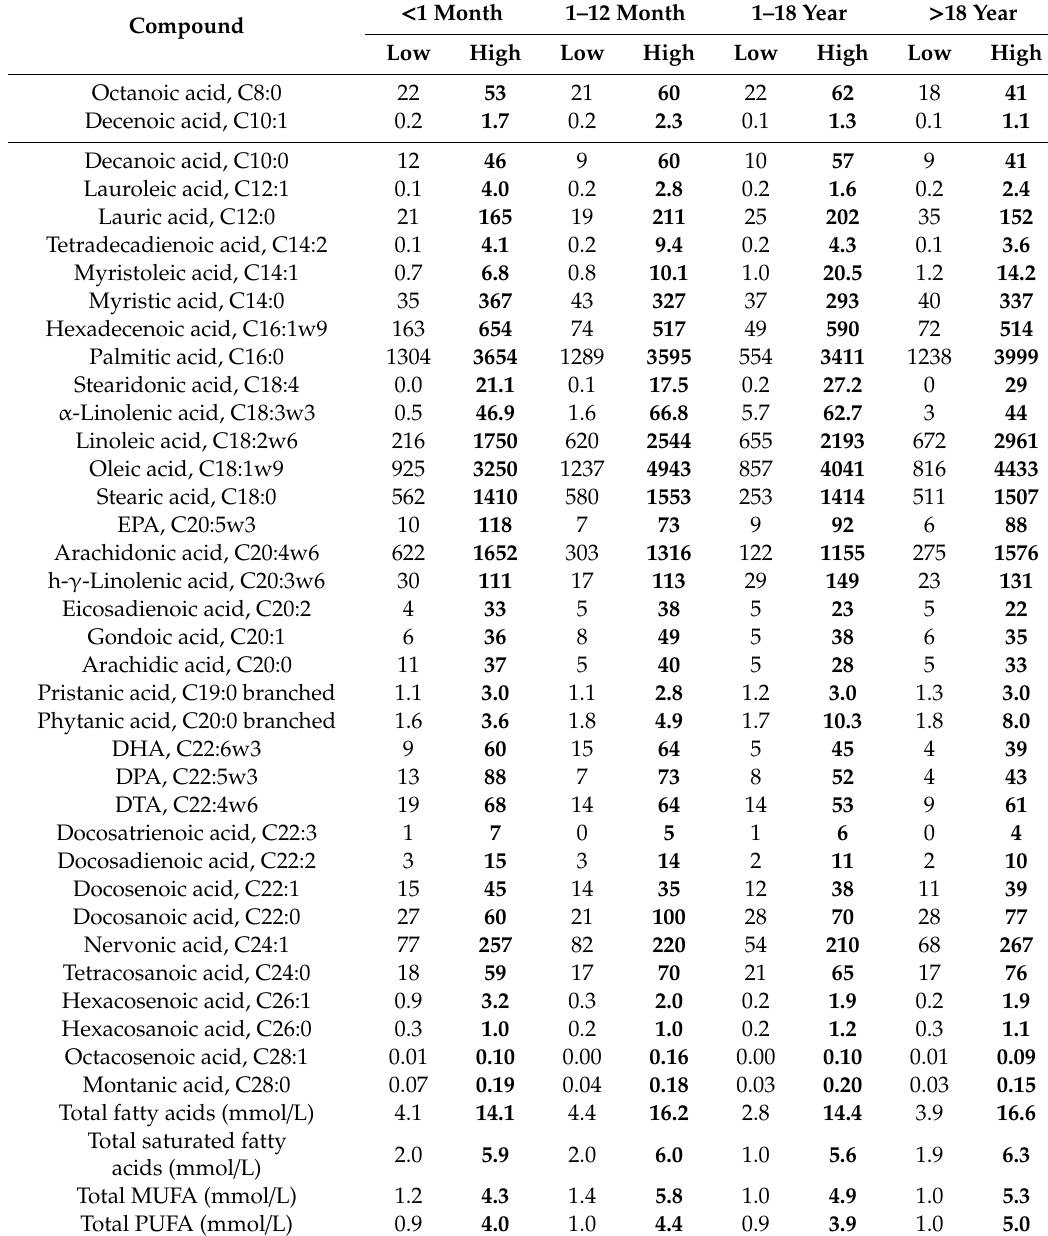
Table 3. Age-stratified reference intervals of total fatty acids in plasma ( µ mol /